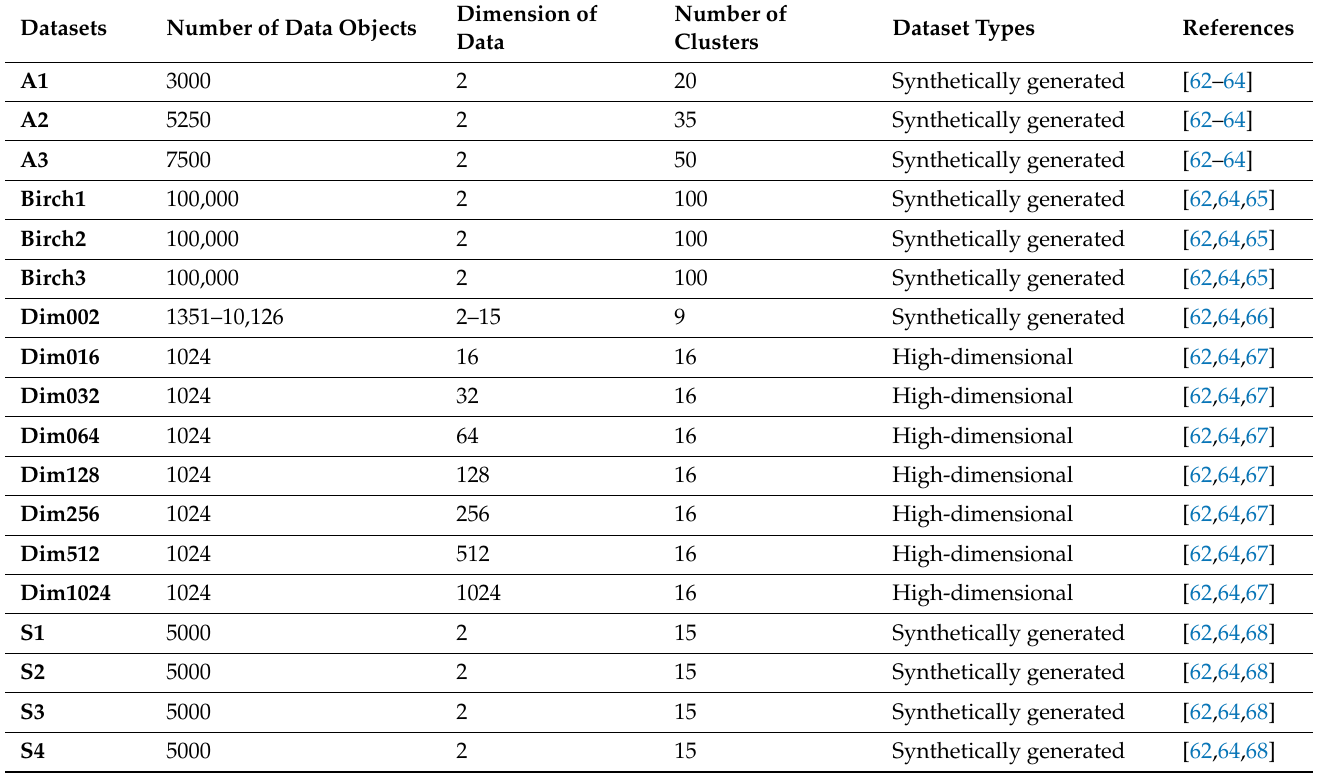
Table 2. The characteristics of the 18 synthetically generated